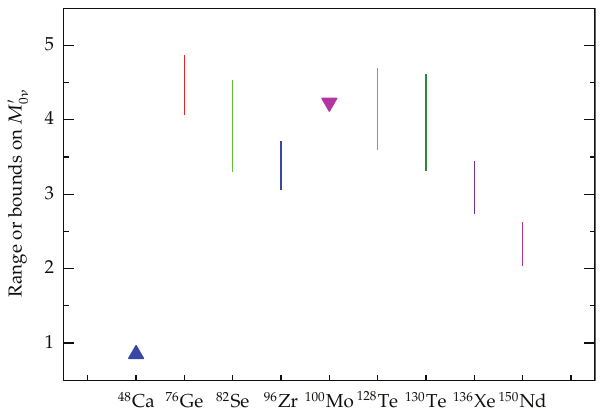
Figure 7: Proposed ranges of the NME values for some selected decays (cid:2) see text (cid:3)